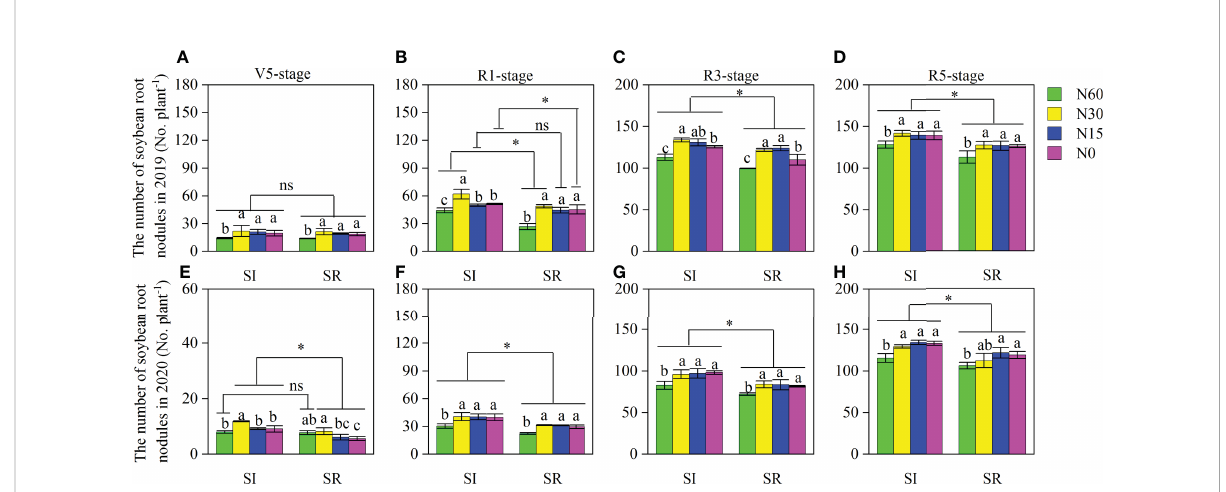
FIGURE 4 Effects of straw incorporation and N application on root nodule number per plant of intercropped soybean at different growth stages. Different lower-case letters indicate signi fi cant differences under different N application rates ( LSD , P < 0.05). Data were shown as mean ± S.D. (n=3). The asterisk “ * ” and “ ns ” indicate signi fi cant differences ( P < 0.05) and insigni fi cant differences ( P >0.05) between straw incorporation and straw removal, respectively. SI, straw incorporation; SR, straw removal; N60, convention N (60 kg N ha -1 ); N30, reduced N by 50% (30 kg N ha -1 ); N15,